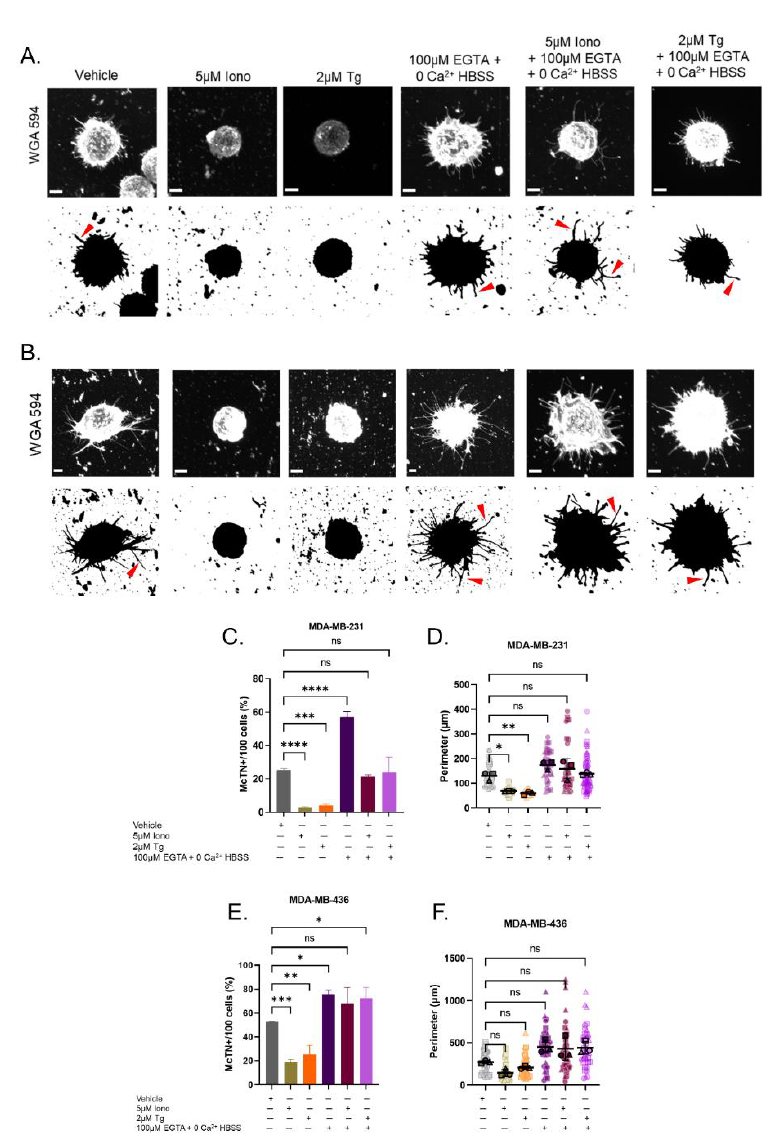
Figure 3. Induce elevation of cytoplasmic Ca 2+ with Ionomycin or Thapsigargin suppresses McTNs in the presence of extracellular Ca 2+ . ( A , B ) Representative single cell maximum intensity confocal images (wheat germ agglutinin (WGA) 594 (1:100)) and their black and white contrast counterparts shown. MDA-MB-231 and MDA-MB-436 cells treated with vehicle (0.5% DMSO), 5µM Ionomycin, 2 µM Thapsigargin, 100 µM ethylene glycol- bis(β -aminoethyl-ether)- N,N,N’,N’ -tetra acetic acid (EGTA) supplemented with Hank ’ s Balanced Salt Solution without Ca 2+ , or 100µM EGTA supplemented with Hank ’ s Balanced Salt Solution without Ca 2+ and 5 µM Ionomycin or 2 µM Thapsigargin. Arrows indicating microtentacles on the cell. Scale bar = 5 μM . ( A ) MDA-MB-231 cells treated with 5 µM Ionomycin or 2 µM Thapsigargin in full Ca 2+ shows a suppression of McTN formation. ( B ) 5 µM Ionomycin or 2 µM Thapsigargin treatment in MDA-MB-436 cells displays a suppression of McTN formation. ( C ) MDA-MB-231 cell positivity for microtentacle formation decreases with Ionomycin or Thapsigargin treatment in full Ca 2+ conditions. ( D ) MDA-MB-231 whole cell perimeter significantly decreases with Ionomycin or Thapsigargin treatment in the presence of extracellular Ca 2+ . ( E ) MDA-MB-436 cell positivity for McTN formation decreases with Ionomycin or Thapsigargin treatment in full Ca 2+ conditions. ( F ) MDA-MB-436 whole cell perimeter does not significantly decrease with Ionomycin or Thapsigargin treatment in the presence of extracellular Ca 2+ . ( C , E ) Data shown as mean ± SD, n = 3. ( D , F ) Data shown as mean ± SD, n = 3, determined from a total of 20 to 30 cells from combined biological replicates. n.s., * p < 0.05, ** p < 0.01, *** p < 0.001, and **** p < 0.0001.